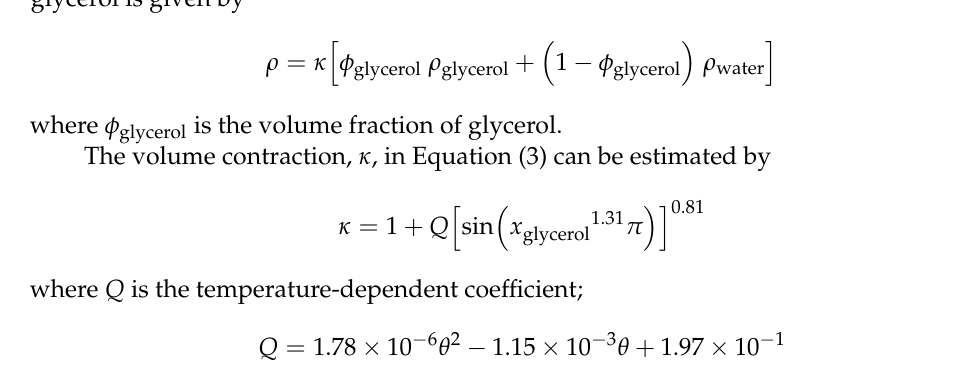
Figure 3. Variation of density of glycerol solutions versus the mass fraction of analytical glycerol between 0.7 and 1 and the respective trendlines.